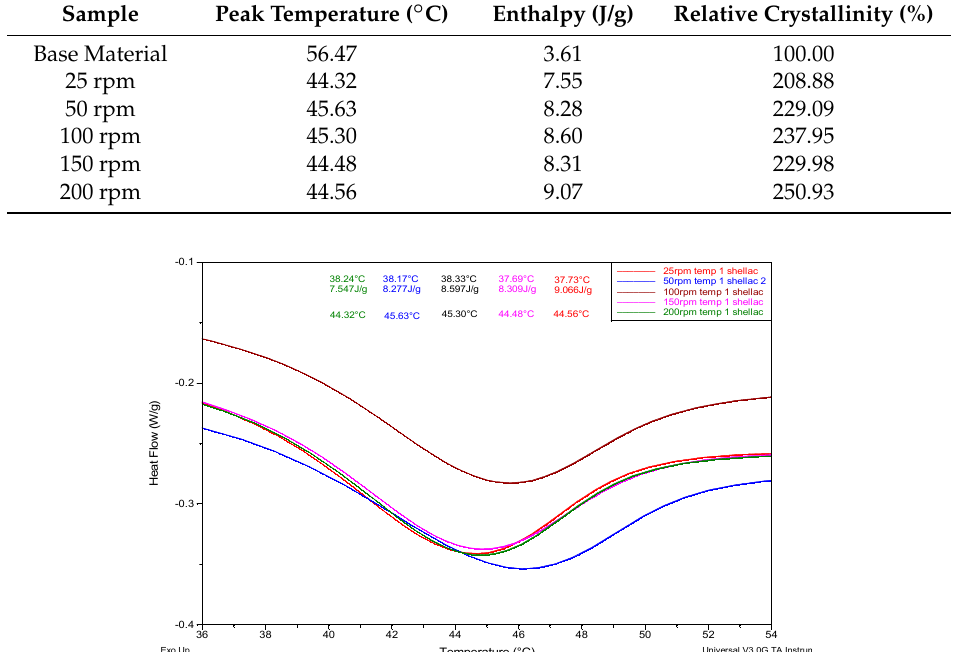
Figure 4. Overlay of DSC thermograms of samples from SSB ® 55 Pharma grade Shellac with increased screw speeds.